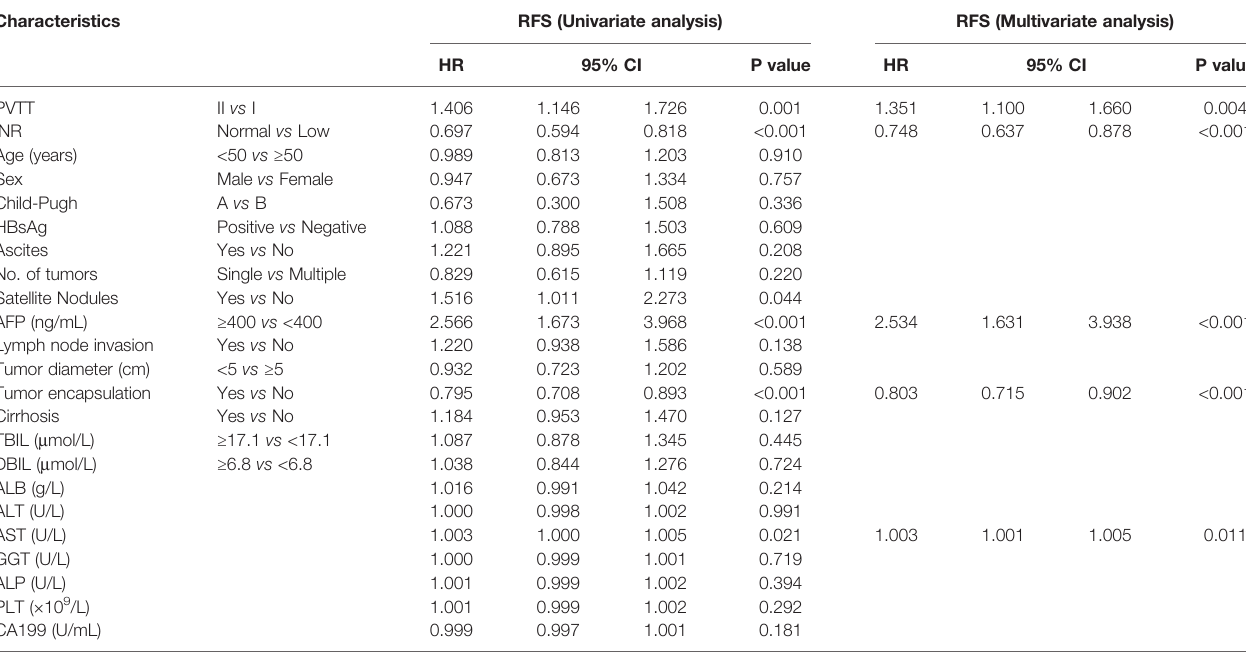
TABLE 3 | Univariate and multivariate analysis of recurrence-free survival of 592 patients with types I/II PVTT who underwent R0 LR.